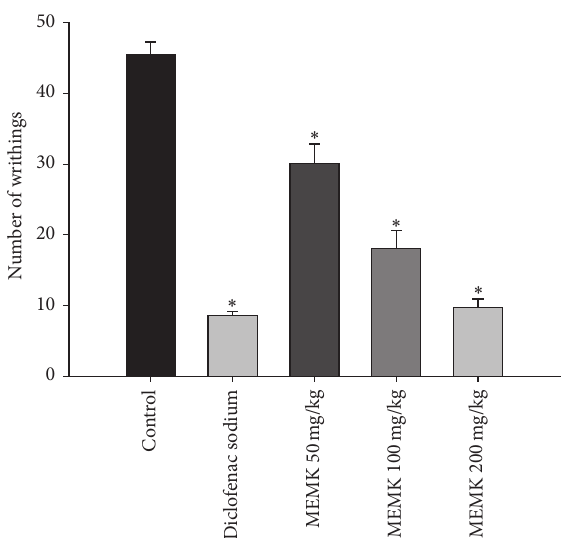
Figure 2: Effects of MEMK in the nociception induced by 0.6% aceticacidinmice.Eachgrouprepresentsthemean ± SEM( 𝑛 =5–7). Statistical analysis was performed using one-way ANOVA followed by Dunnett’s post hoc test. ∗ 𝑝 < 0.01 compared to control.